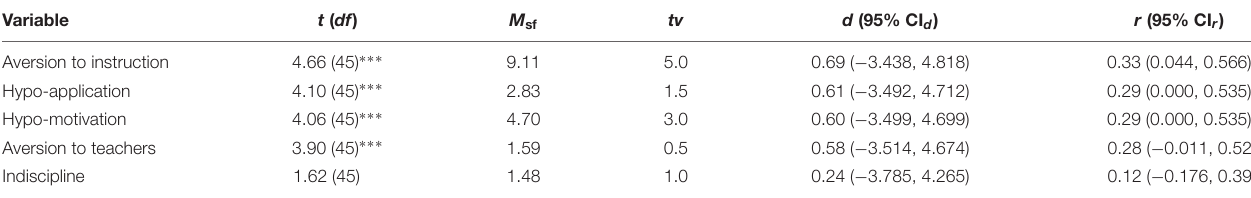
TABLE 3 | One sample t -test for the sub-dimensions of scholar maladjustment at level 2. Variable